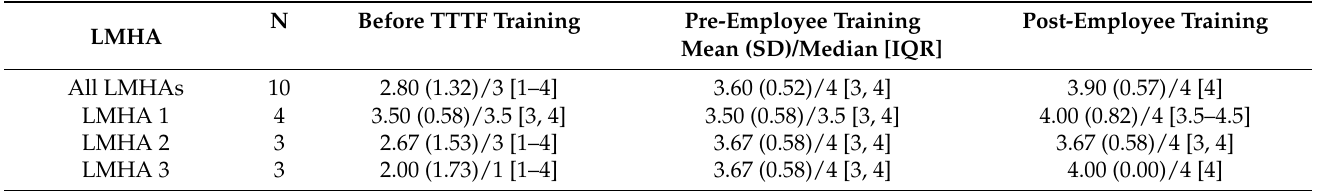
Table 2. Champions’ Self-reported Self-efficacy by Local Mental Health Authorities Over Time.